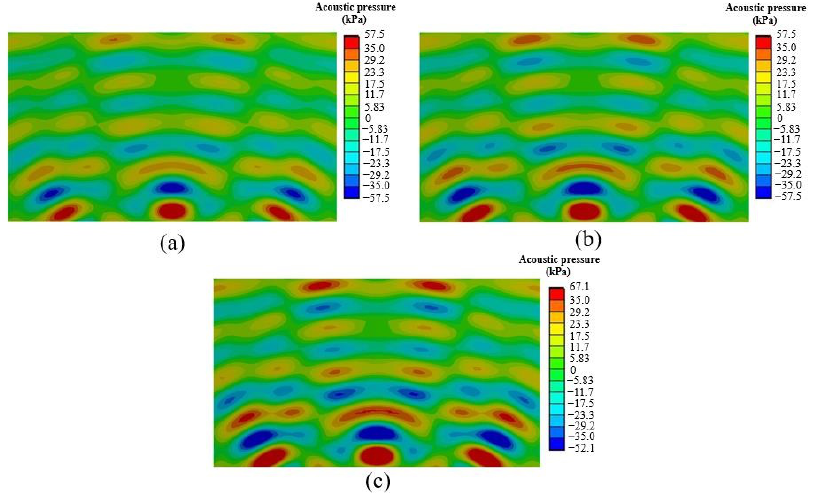
Figure 9. Acoustic pressure distribution from the TDA of 40 kHz UCT for transducer power of ( a ) 300, ( b ) 350, and ( c ) 400 W.